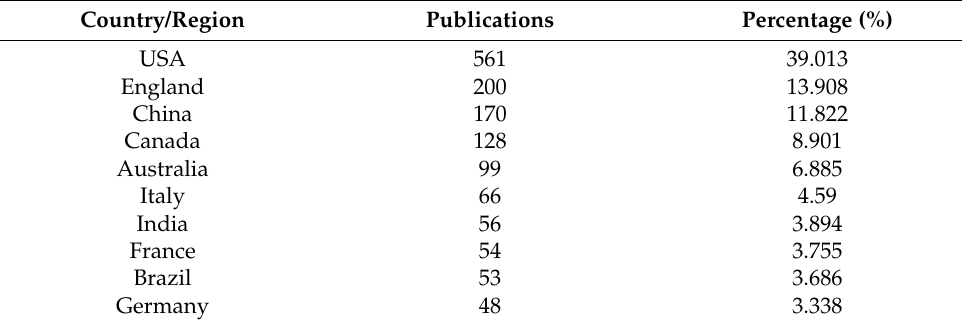
Table 4. The top 10 productive countries/region.